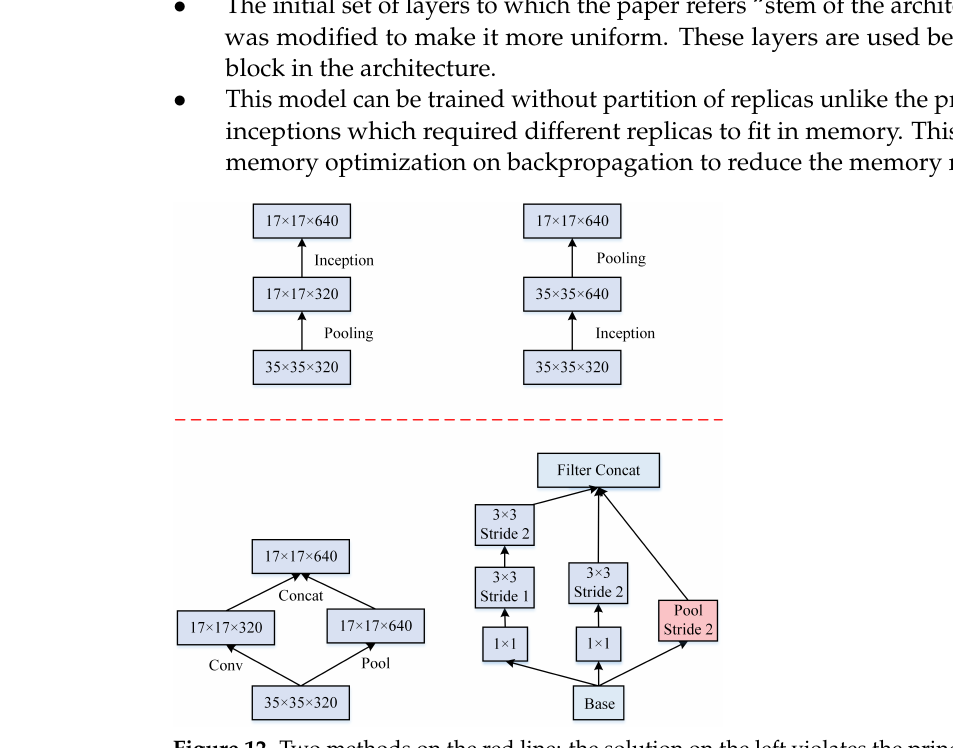
Figure 12. Two methods on the red line: the solution on the left violates the principle [1]. The version on the right is 3 times more expensive computationally. Method under the red line: an efficient grid size reduction module is both cheap and avoids the representational bottleneck as is suggested by principle [1].